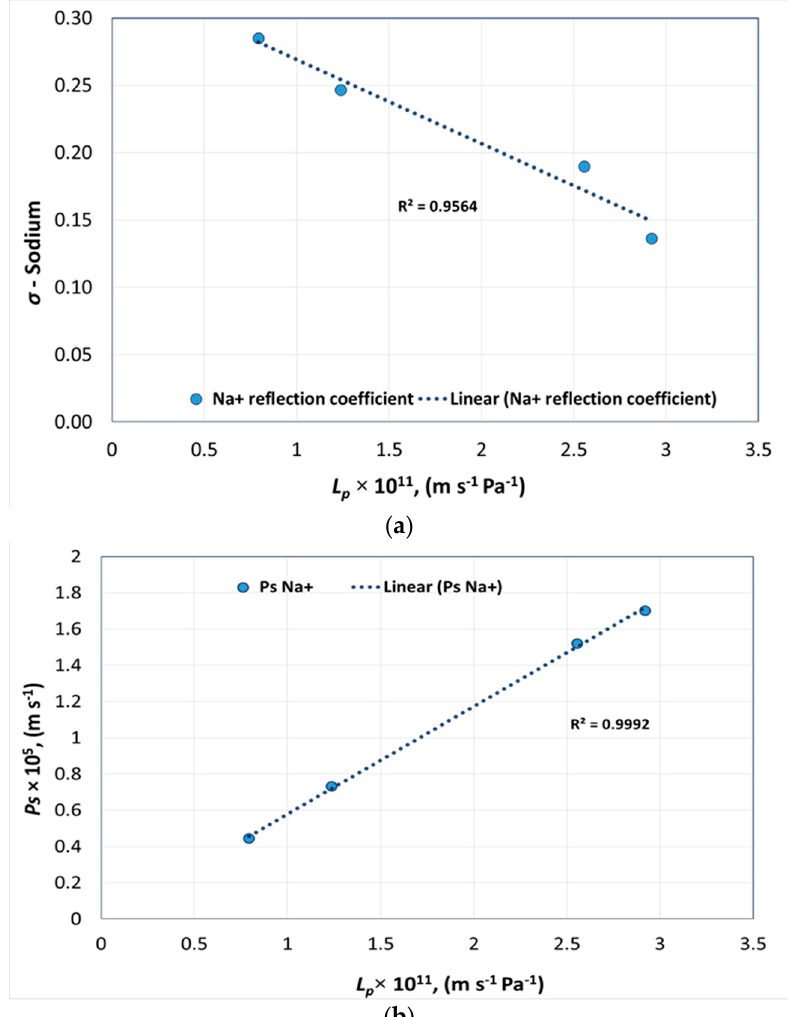
Figure 4. Pure water permeability versus ( a ) reflection coefficient and ( b ) solute permeability of sodium.